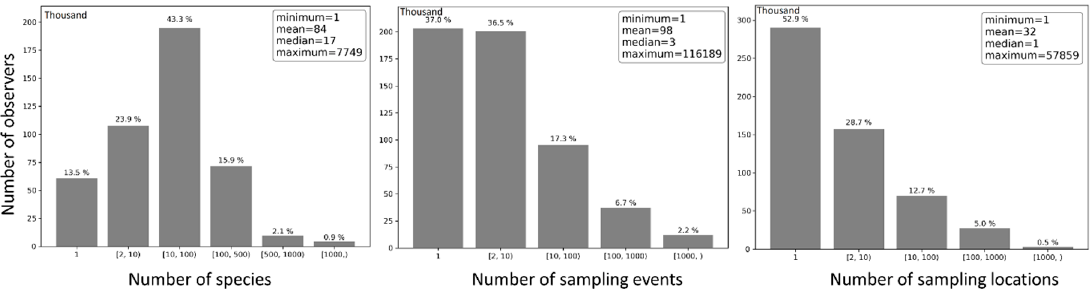
Figure 14. Frequency distribution of observers by number of reported species ( left ), number of sampling events ( center ) and number of sampling locations ( right ).